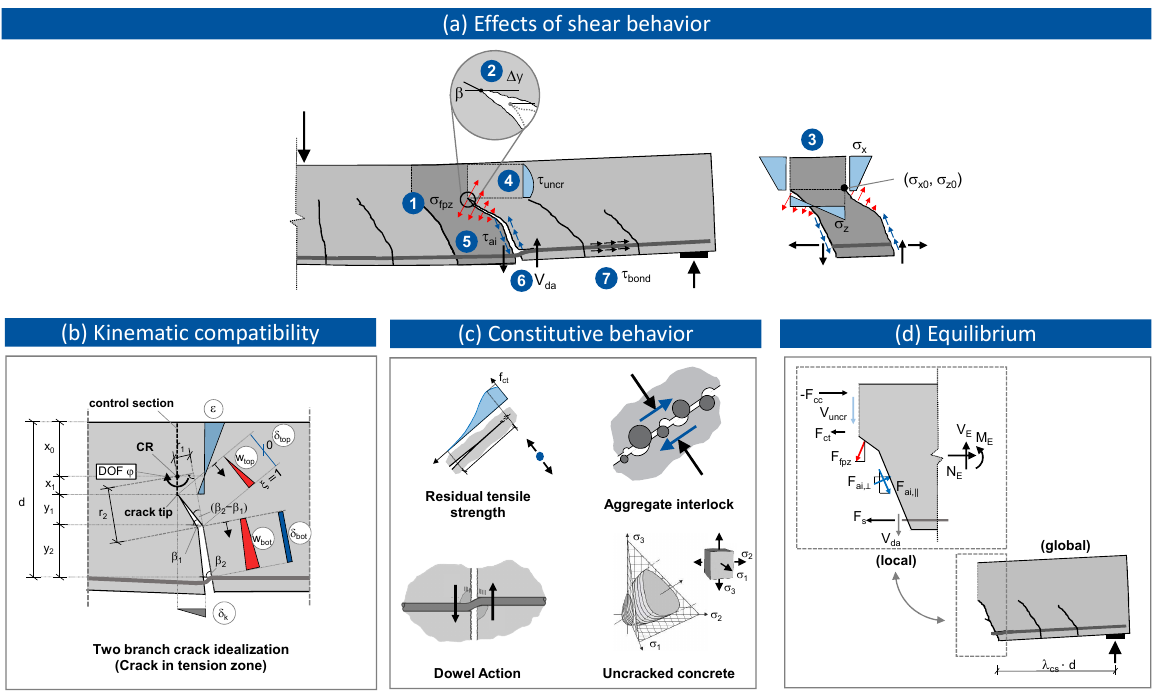
Figure 1. Overview of the Shear Crack Propagation Theory (SCPT) algorithm: ( a ) elementary effects of the shear behavior, ( b ) idealized crack geometry and fracture kinematics, ( c ) constitutive relations and ( d ) shear contributions and